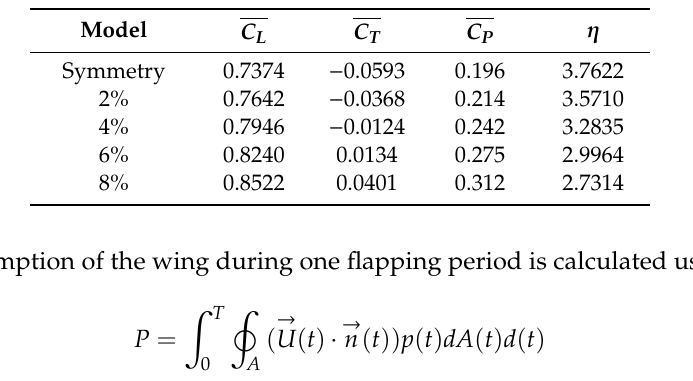
Table 2. Time-averaged aerodynamic parameters for partial advanced